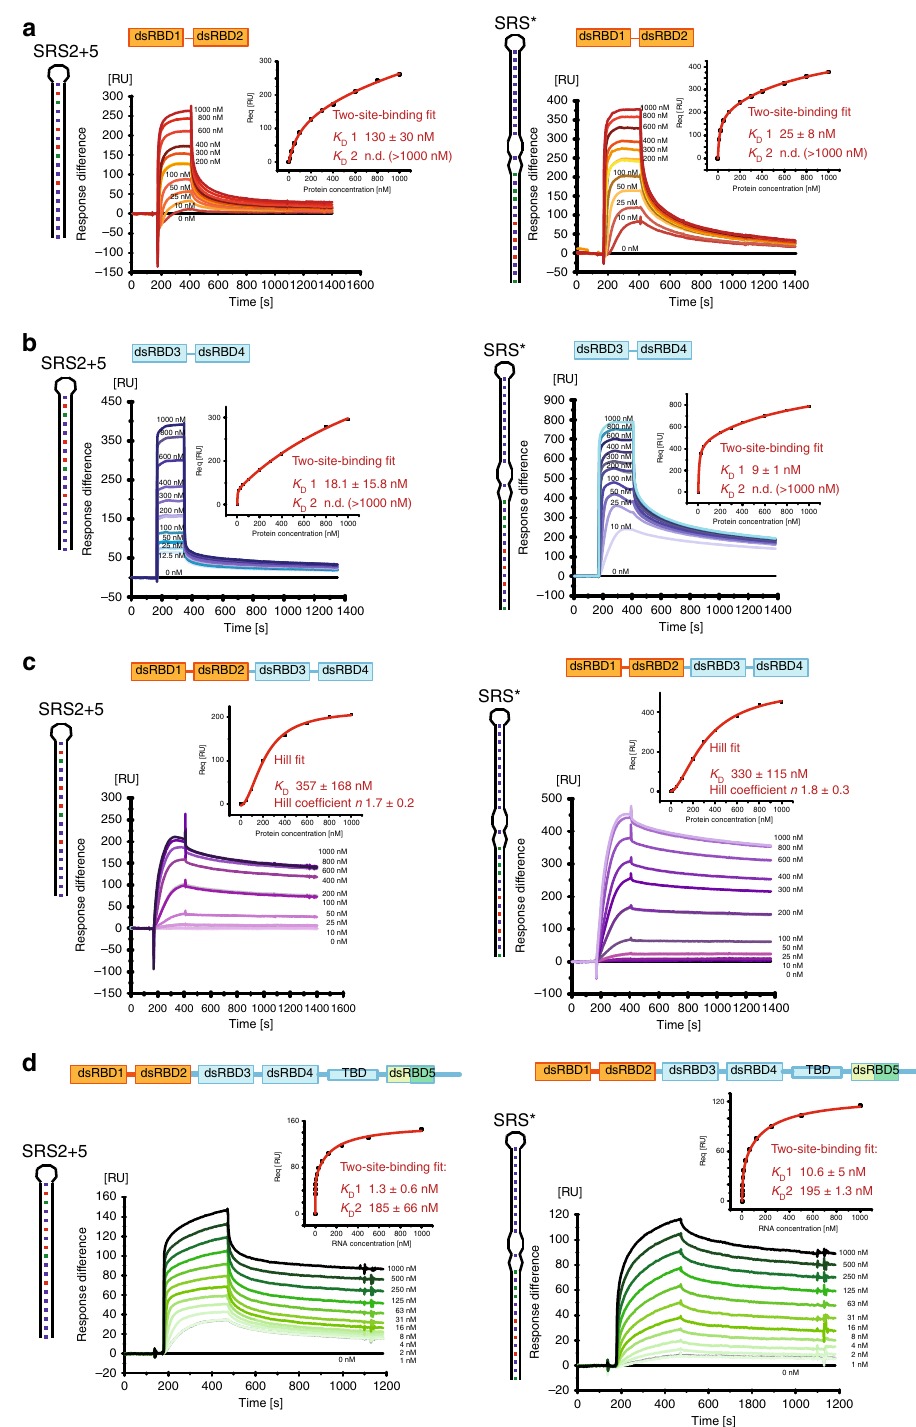
Fig. 2 SPR shows mStau2 binding to SRS2 + 5 RNA and SRS* RNA. a mStau2 dsRBD 1 – 2, and b mStau2 dsRBD 3 – 4 binding to surface-coupled SRS2 + 5 and SRS* RNAs. The tandem domains dsRBD 1 – 2 and dsRBD 3 – 4 bind transiently with fast kinetics. The steady-state binding curves do not saturate up to 1 µ M protein concentration but can be described by a two-site binding fi t with K + 5 and K D 1 of 18 nM and 130 nM, respectively, for SRS2 D 1 of 9 nM and 25 nM, respectively, for SRS*. c mStau2 dsRBD 1 – 4 binding to surface-coupled SRS2 + 5 and SRS* RNAs is stable with slower kinetics. The steady-state binding curve saturates at approximately 1 µ M and is described by a Hill fi t with an apparent overall K D of 357 nM and a Hill coef fi cient n = 1.7 for SRS2 + 5 and an apparent overall K D of 330 nM and a Hill coef fi cient n = 1.8 for SRS*, indicating positive cooperative binding. d SRS2 + 5 and SRS* bind to surface- coupled mStau2 FL stably and with high af fi nity. The steady-state binding curves can be described by a two-site binding fi t with K D 1 of 1.3 nM and 10.6 nM and K D 2 of 185 nM and 195 nM, respectively. ± indicates standard deviation. Source data are provided as a Source Data fi